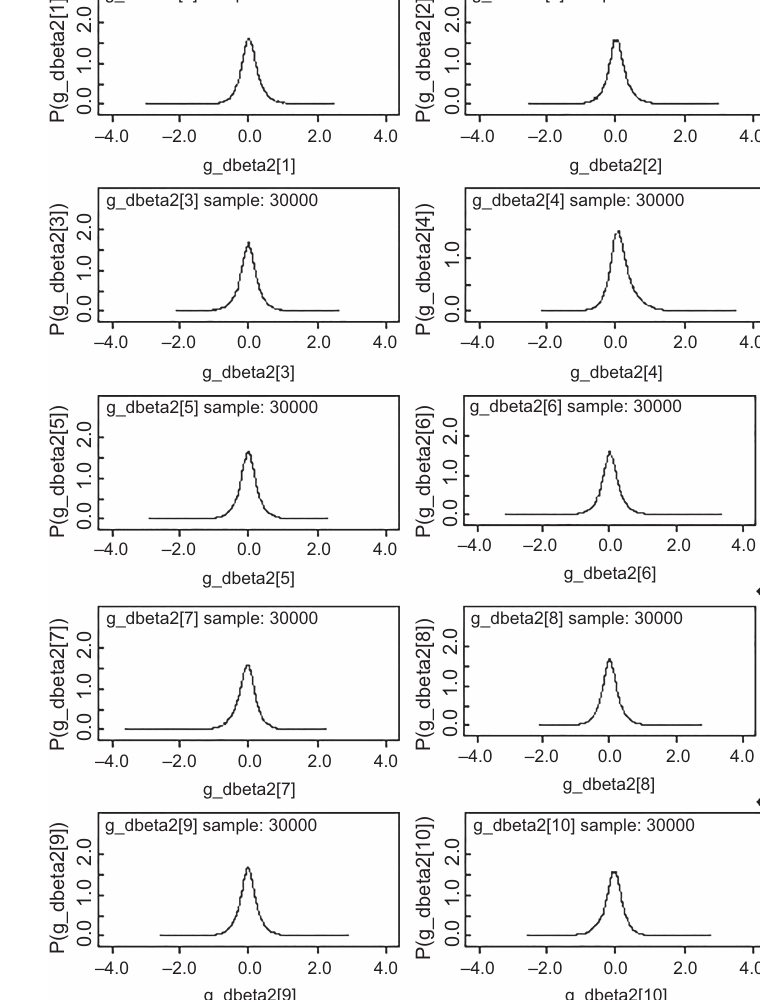
Figure 5. Density plots (selected time periods, k 5 1, 2, ... , 10): Difference between coefficients on economic development and their (default) global